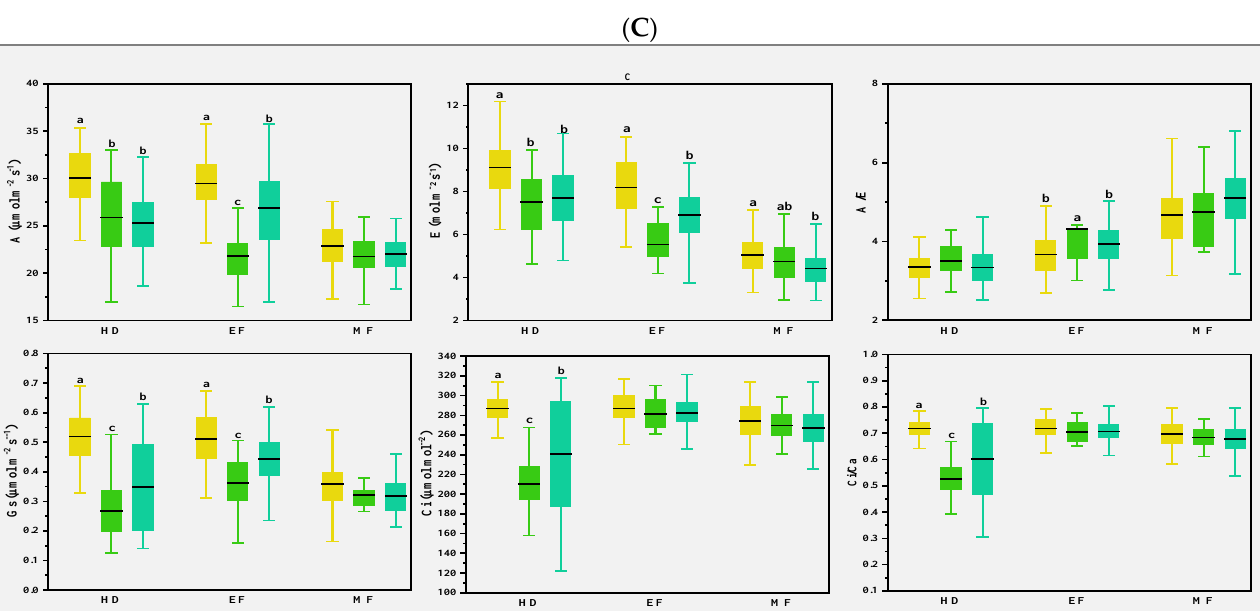
Figure 7. Multiple comparisons of photosynthetic traits among the three clusters based on the CTDs at the growth stages and canopy structural traits of the 2016–2017 ( A ), 2017–2018 ( B ), and 2018–2019 ( C ) growing seasons. The clustering was conducted with the CTDs at the three growth stages and structural traits for each growing season using the Ward method. Then, multiple comparisons were conducted among different clusters using the Duncan method. Different lowercase letters indicate differences significant at the p < 0.05 level. A: net photosynthetic rate; E: transpiration rate; Gs: stomatal conductance; Ci: intercellular CO 2 concentration; A/E: instant water use efficiency; Ci/Ca: stomatal limitation ratio. HD: heading; EF: early filling; MF: middle filling.